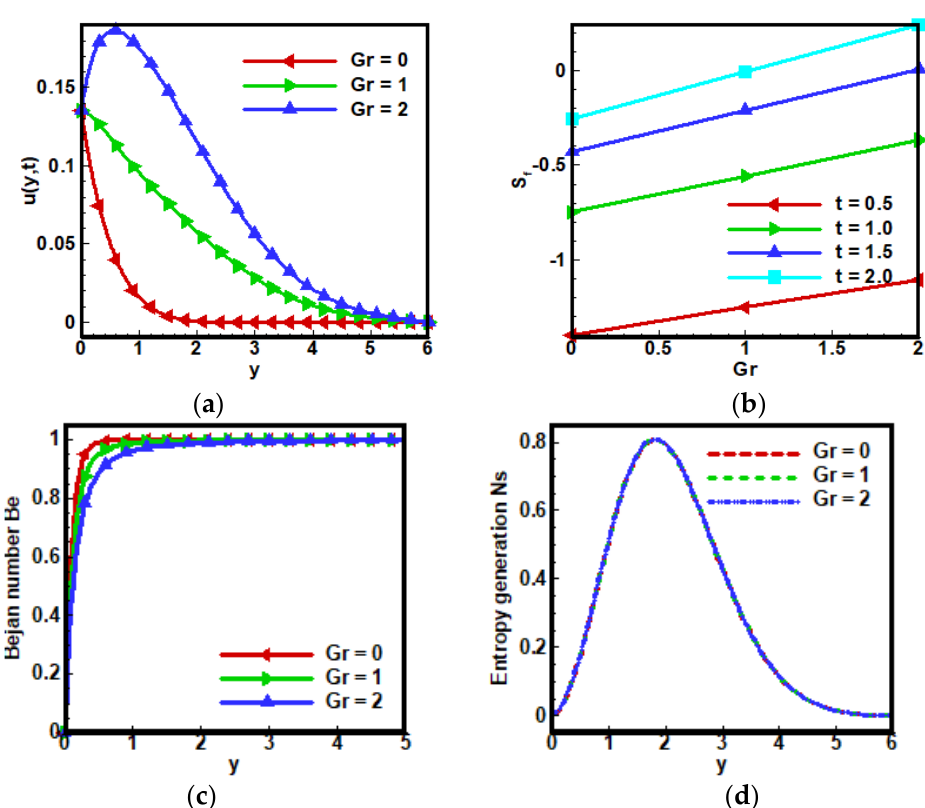
Figure 4. Influence of Grashof number Gr on ( a ) dimensionless velocity profile, ( b ) coefficient of skin friction, ( c ) Bejan number and ( d ) entropy generation when Λ 1 = 0.6, Λ 2 = 0.5, Gr = 5, Ha = 10, Pr = 6, 𝑄 = 5, 𝑁𝑟 = 3.5, 𝑎 = −1, 𝐵𝑟 = 0.5, Ω = 10, 𝜙 = 0.1 .